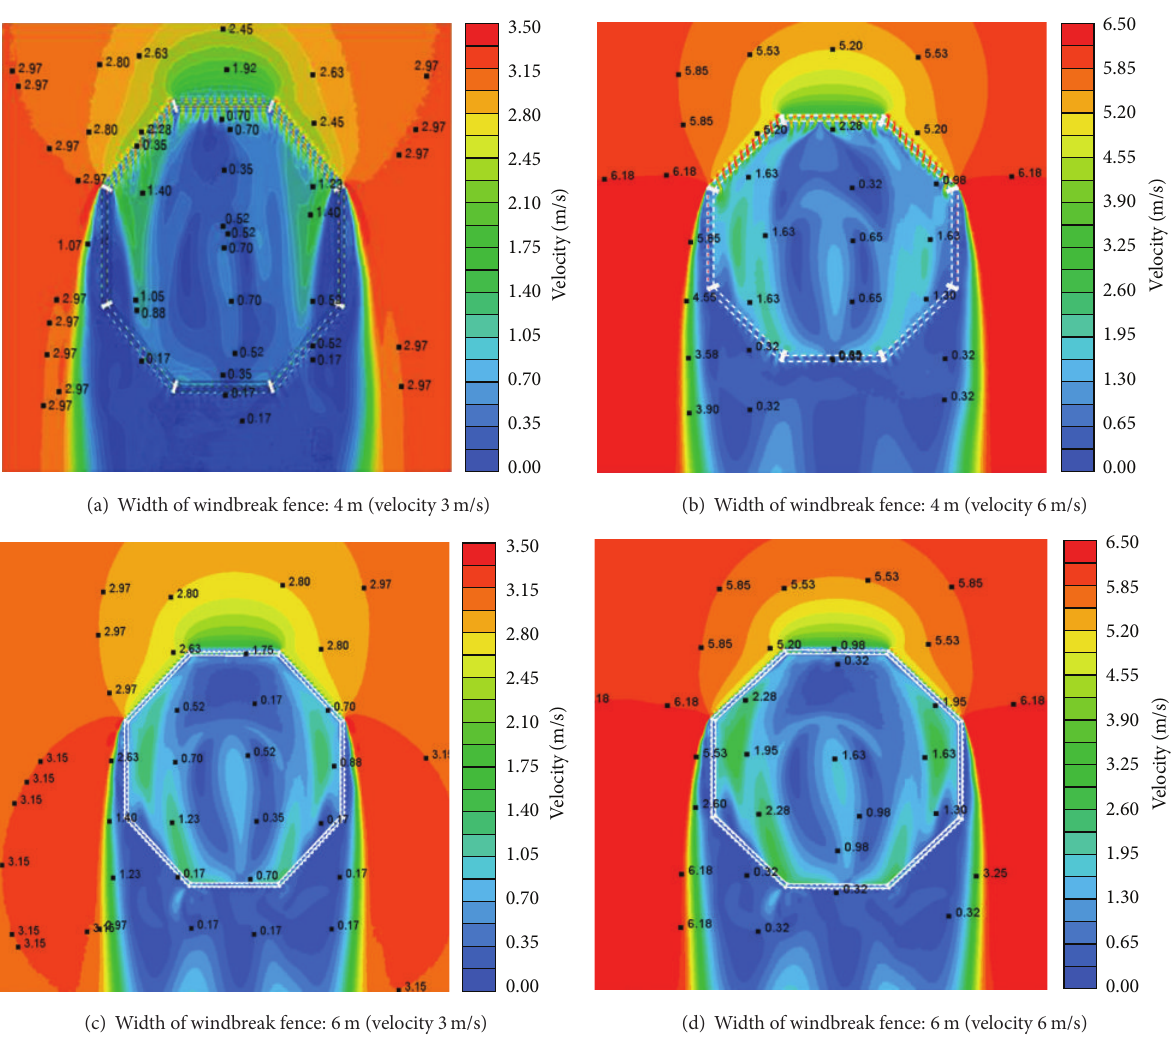
Figure 12: Internal wind velocity flow at a measurement height of 20 cm according to the windbreak fence